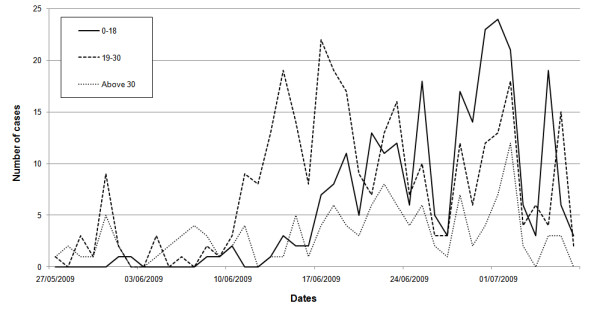
Time series of swine flu cases divided into three different age groups.